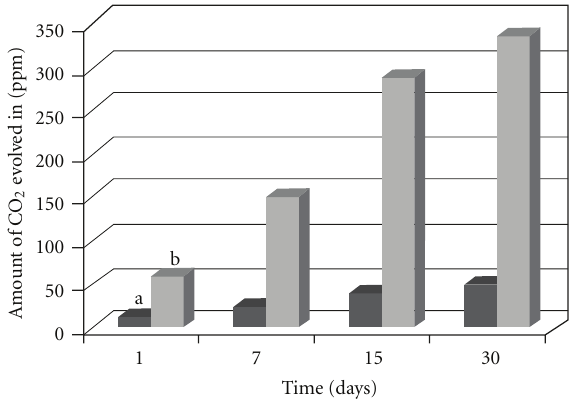
Figure 9: Biodegradation by bacteria ( B. cereus ) of (a) PAN, (b) PAN/MMT (5%w/v) on time versus amount of CO 2